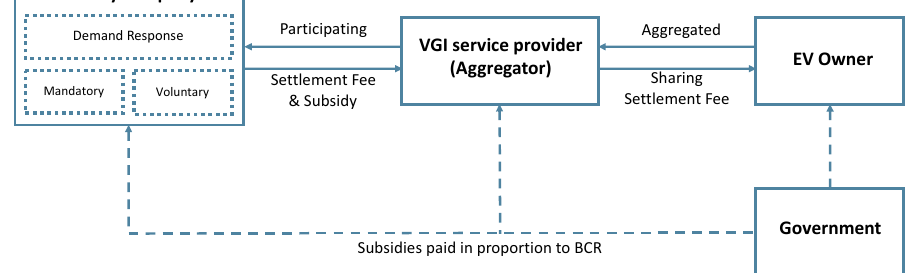
Figure 2. Stakeholders and business model.